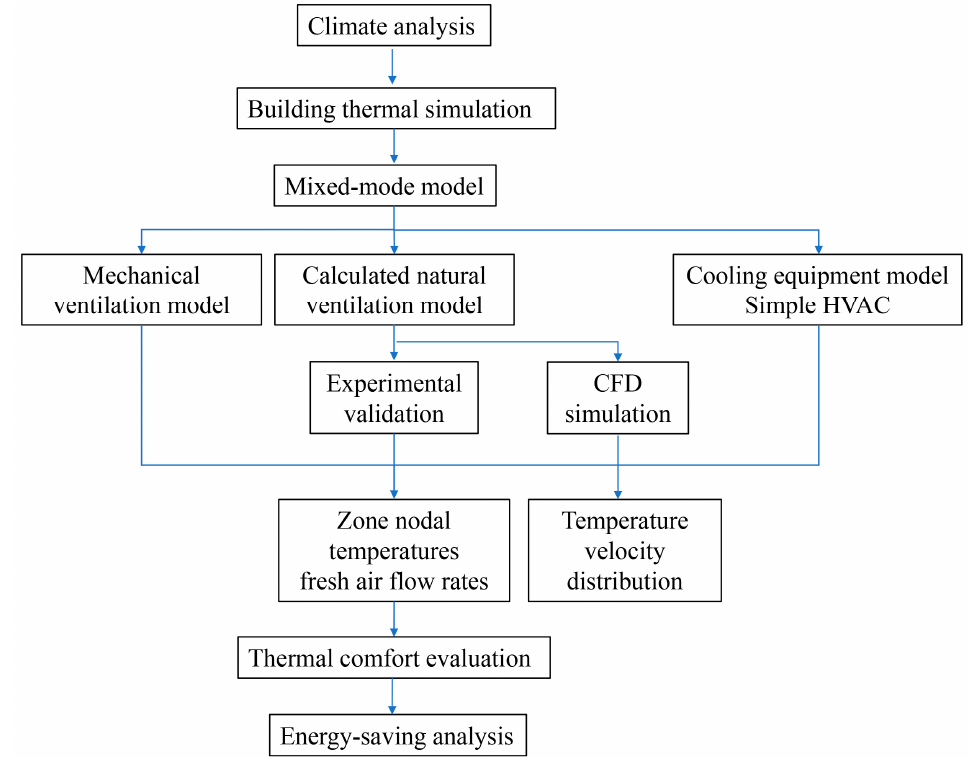
Figure 1. Flow chart of the research method used in the paper.